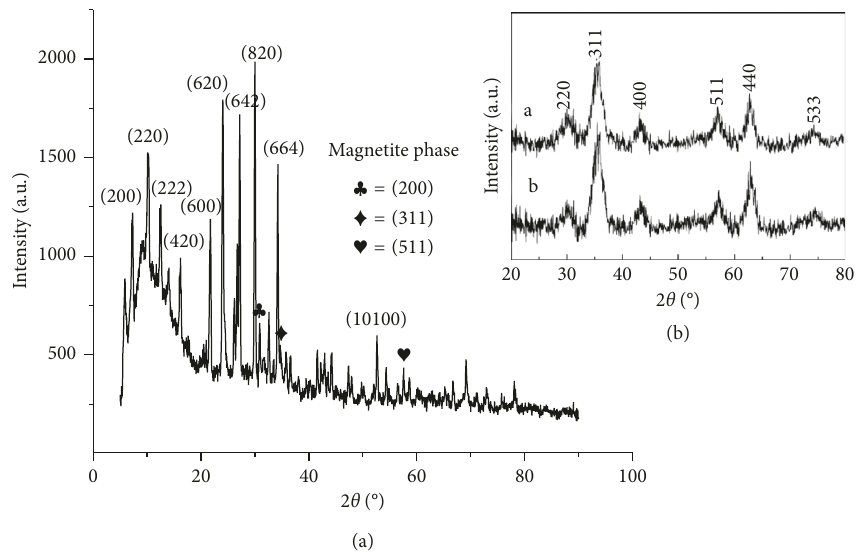
Figure 2: (a) XRD pattern of synthesized zeolite/magnetite nanocomposite; (b) XRD of magnetite (Fe